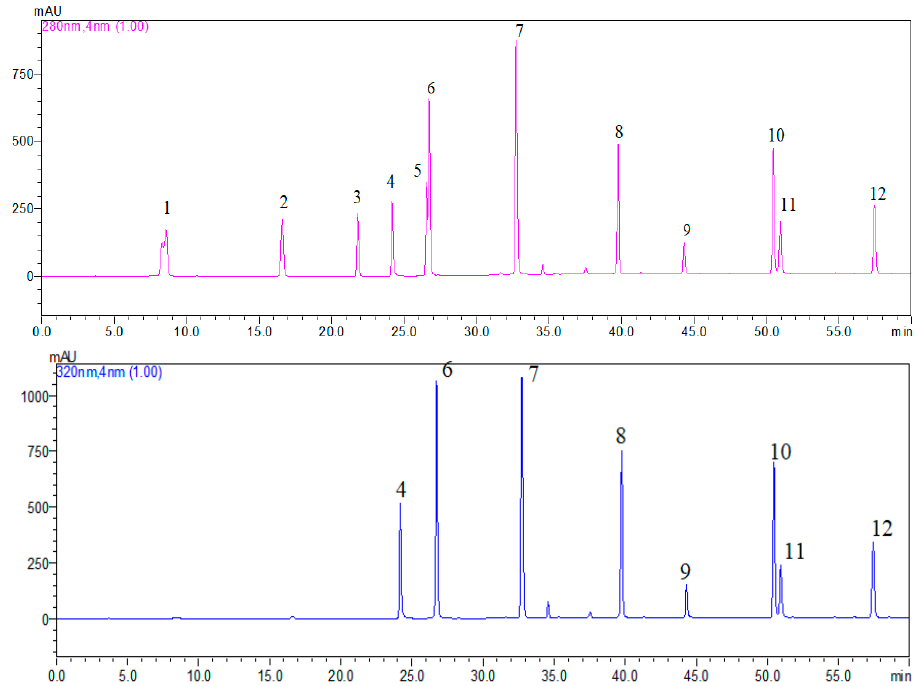
Figure 1. HPLC-DAD chromatogram at 280 nm and 320 nm for the standard (100 mg/L) for gallic acid (peak 1 (8.578 min)), protocatechuic acid (peak 2 (16.6 min)), p -hydroxybenzoic acid (peak 3 (21.8 min)), caffeic acid (peak 4 (24.2 min)), vanillic acid (peak 5 (26.6 min)), chlorogenic acid (peak 6 (26.7 min)), p -coumaric acid (peak 7 (32.7 min)), rosmarinic acid (peak 8 (39.8 min)), myricetin (peak 9 (44.3 min)), luteolin (peak 10 (50.5 min)), quercetin (peak 11 (50.9 min)) and kaempferol (peak 12 (57.4 min)).